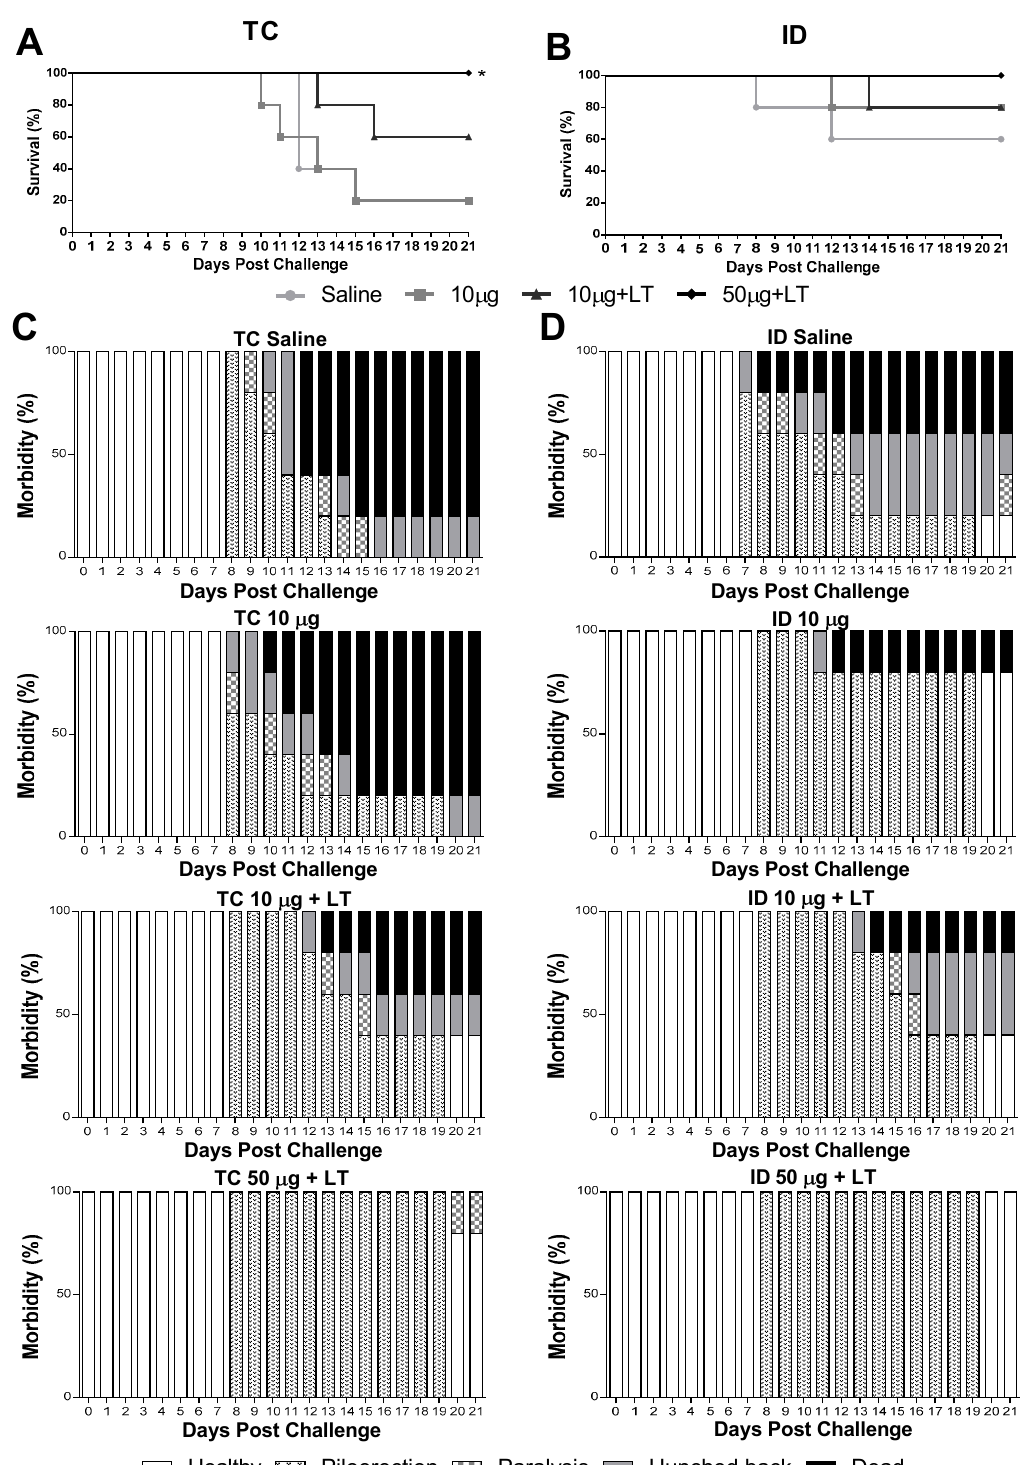
Figure 4. Protective immunity induced in mice after immunization via TC or ID routes with DENV2 New Guinea C (NGC). Survival and morbidity curves were mounted after inoculation of lethal intracranial (i.c.) challenge with 1 × 10 6 NGC virus particles 2 weeks after the 3rd immunization dose ( n = 5). ( A , B ) Survival curves of mice immunized via TC ( A ) or ID ( B ) routes following a lethal challenge with the DENV2 NGC strain. ( C , D ) Morbidity curves of mice immunized via TC ( C ) or ID ( D ) routes following the lethal challenge. Statistical analysis performed by Mantel–Cox test. * p <